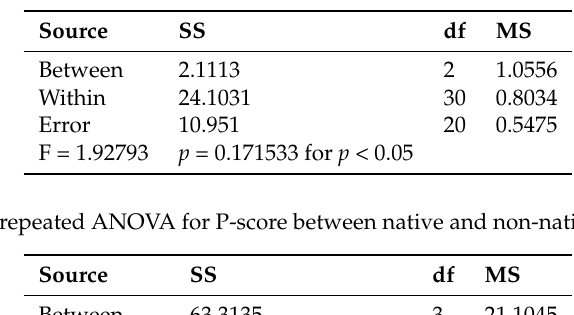
Table 8. One-Way Repeated ANOVA for P-score between medical first year, second year, and nursing groups.